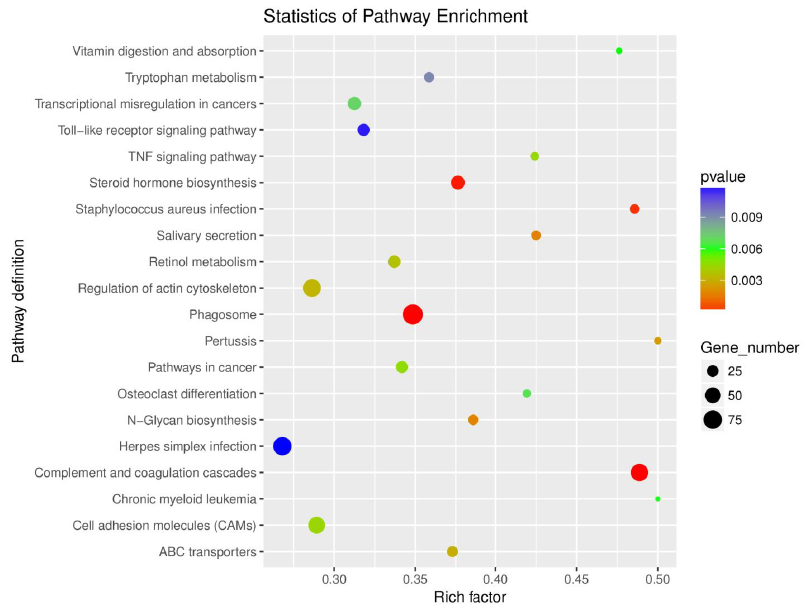
Figure 4. Scatterplot of enriched KEGG pathways for